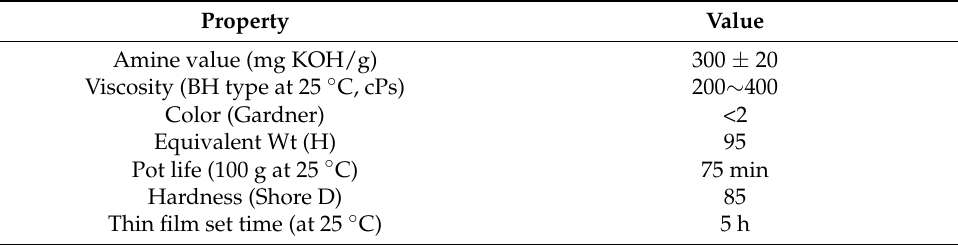
Table 2. Properties of Jointmine 905-3S.